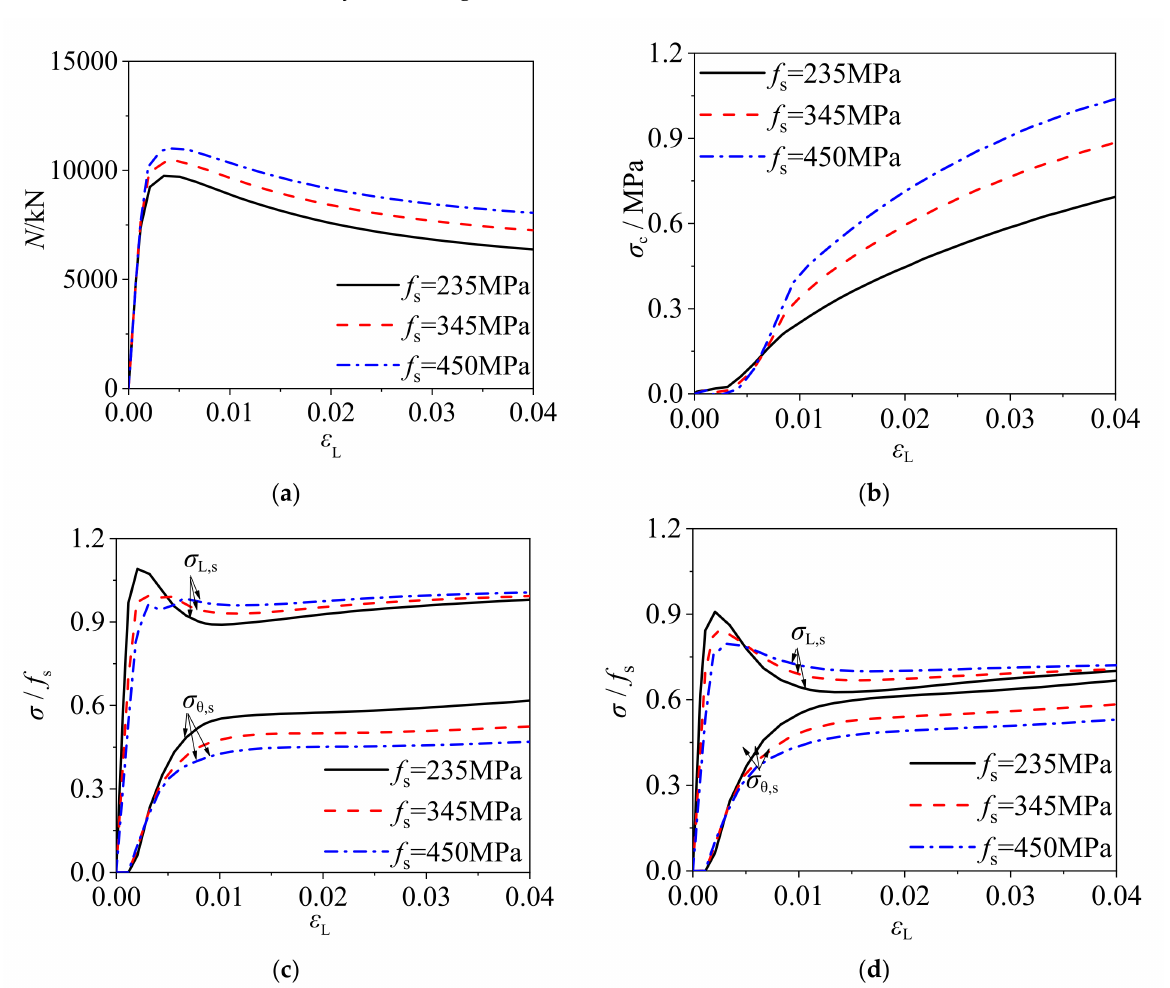
Figure 10. The influence of steel yield strength on the mechanical performance of CFCFST stub columns: ( a ) load–strain curves, ( b ) radial stress–strain curves of core concrete, ( c ) stress to yield strength–strain curves of steel tubes at endpoint, and ( d ) stress to yield strength-strain curves of steel tubes at